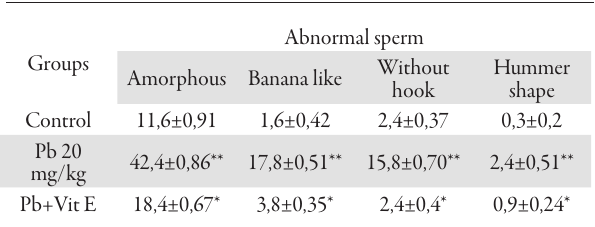
Tab. 2. Effect of Vit E on sperm character of lead acetate